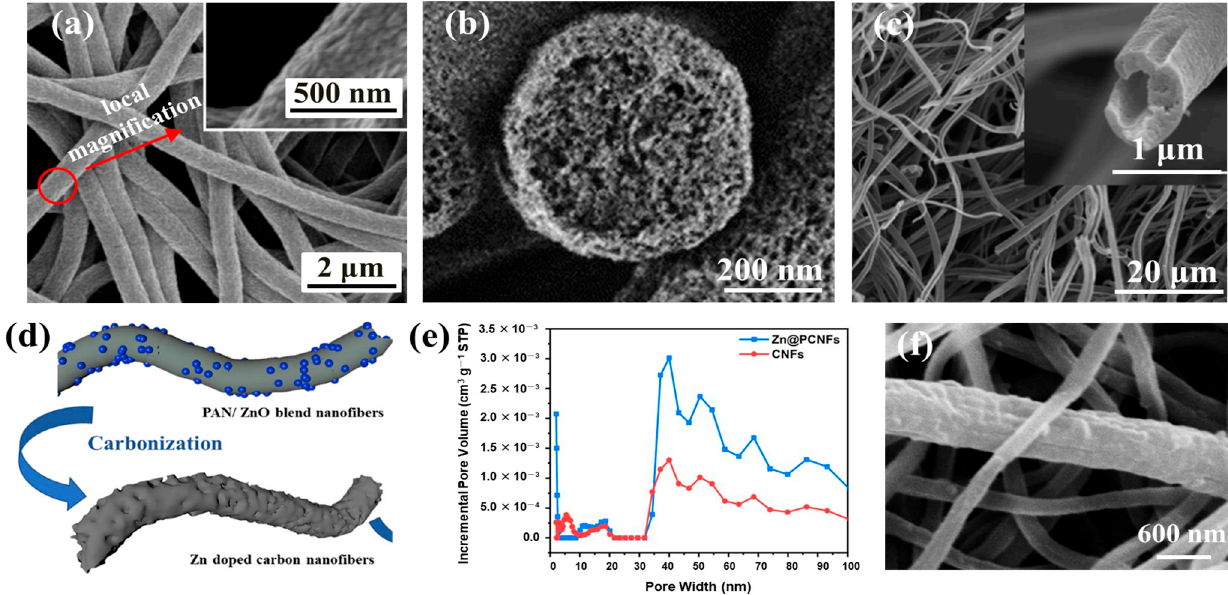
Figure 2. ( a ) SEM image of porous PAN nanofibers after amination. Reprinted with permission from Ref. [89], Copyright 2015, The Royal Society of Chemistry. ( b ) SEM image of cross-section of porous POM/PLLA nanofiber after chloroform immersion. Reprinted with permission from Ref. [92], Copyright 2016, The Royal Society of Chemistry. ( c ) SEM image of hollow, porous carbon nanofibers. Reprinted with permission from Ref. [31], Copyright 2021, Elsevier. ( d ) Schematic for the preparation of Zn@PCNFs and ( e ) pore size distribution of CNFs and Zn@PCNFs. Reprinted with permission from Ref. [97], Copyright 2022, American Chemical Society. ( f ) SEM image of porous PVDF/PAN nanofibers after HCl extraction. Reprinted with permission from Ref. [105], Copyright 2018,